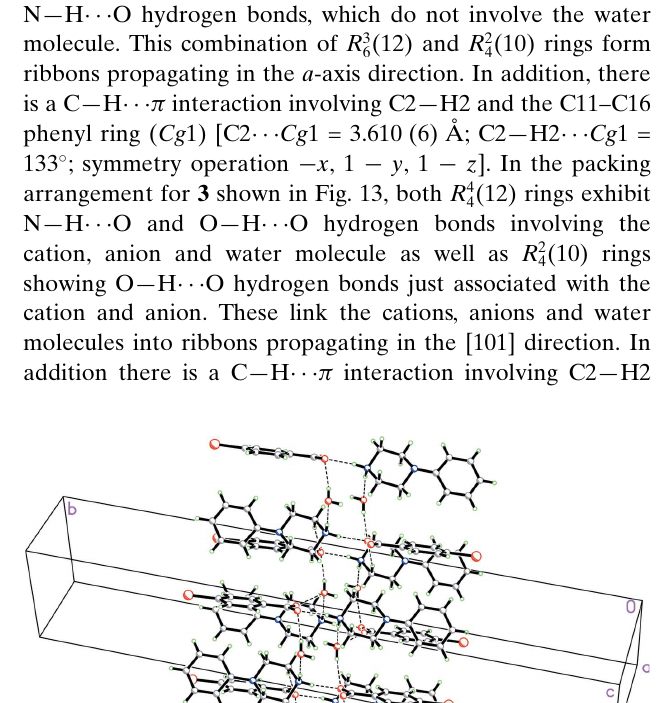
(10) rings made up of 4 (12) and R 2 (10) rings form 4 6